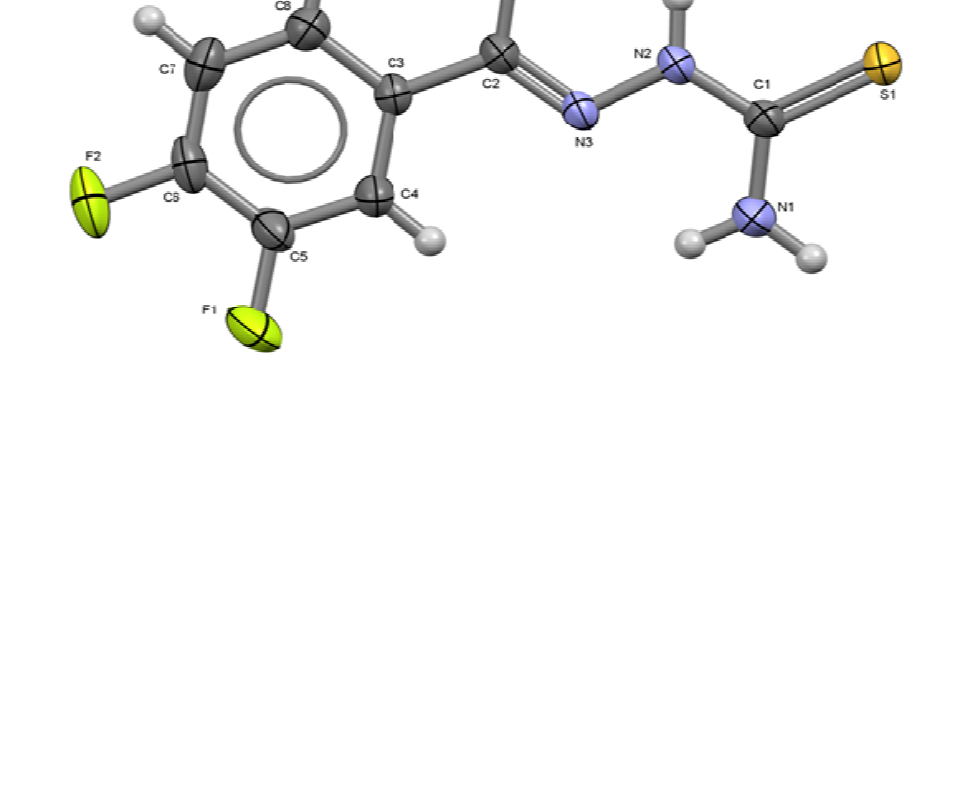
H F -CH=N-NH-C(S)NH ( 3 , molecule A). Thermal 6 3 2 2